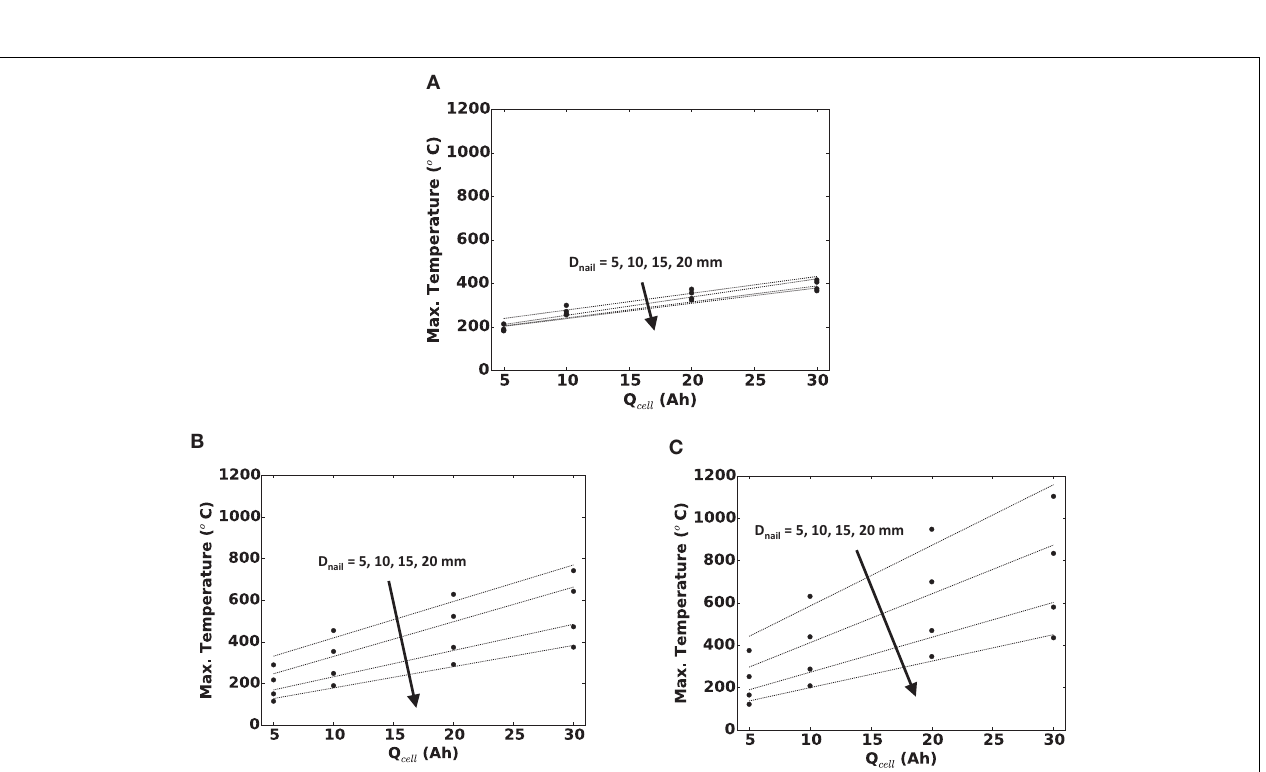
FIGURE 6 | Maximum local temperature versus cell capacity ( Q cell ) for (A) small A foil , (B) medium A foil , and (C) large A foil .